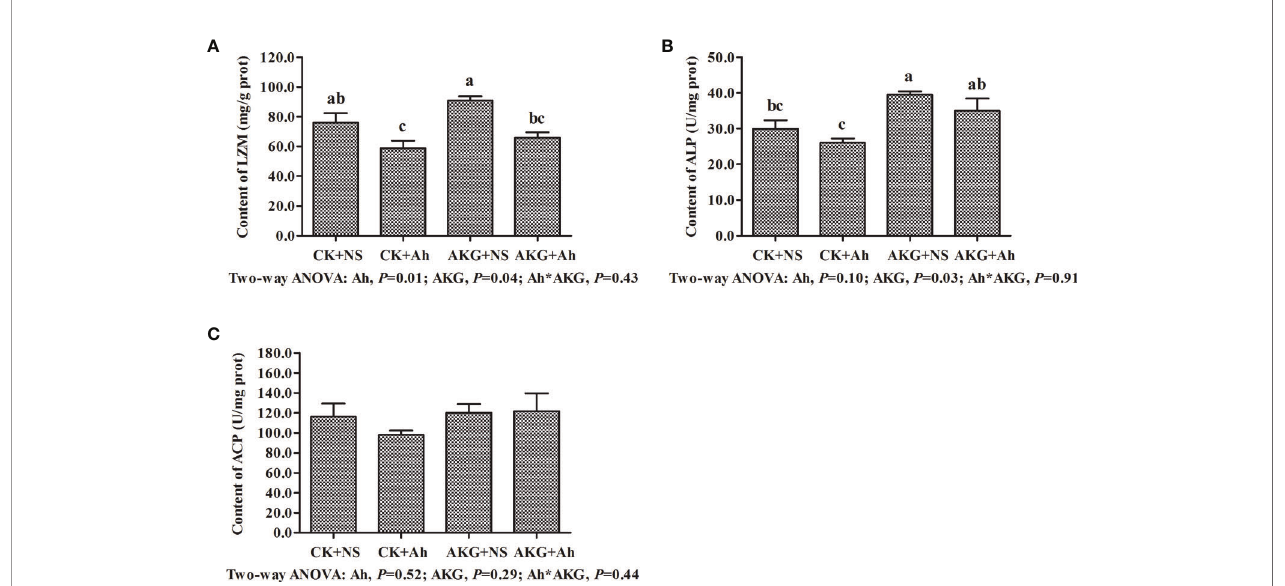
FIGURE 2 | Effects of AKG supplementation and A hydrophila infection on immune-related enzymes in intestine of Songpu mirror carp ( Cyprinus carpio ). (A) LZM, lysozyme; (B) ALP, alkaline phosphatase; (C) ACP, acid phosphatase. All of the values are expressed as the means ± SEM. Values with different letters are signi fi cantly different ( P <